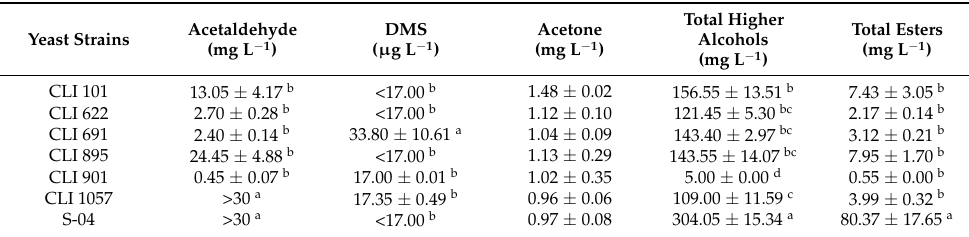
Table 2. The main analytical characteristics of six non-conventional strains and S-04 in 400 mL fermentation analyzed with